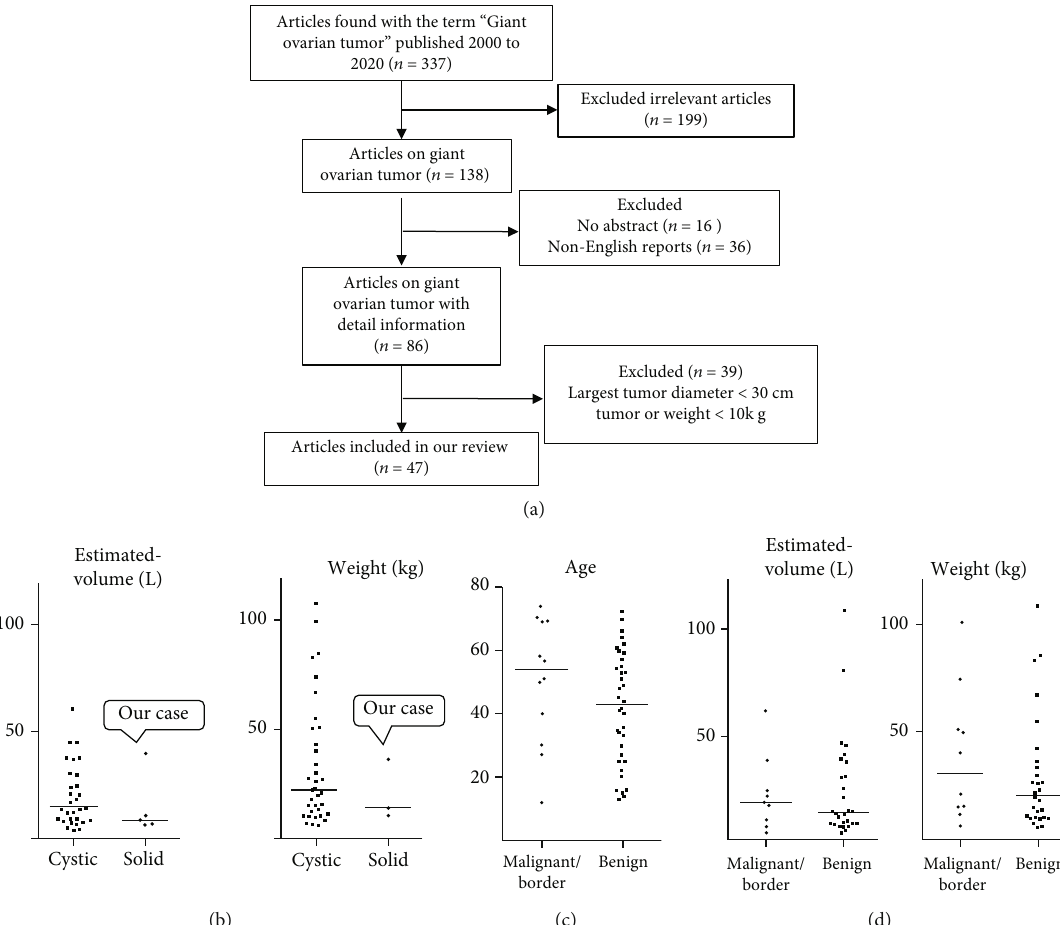
Figure 4: Literature review: fl ow and comparison of cystic and solid, begin, and borderline/malignancy. (a) Schematic of review. Case reports published from 2000 to 2020 were searched. We de fi ned ExG-OvTs as (1) tumors with a maximum diameter > 30cm in imaging or (2) tumors weighing more than 20kg. As a result, 48 cases were reviewed including our case. (b) Comparison of estimated volume (left side) and weight (right side) between cystic and substantial tumors. (c) Comparison of age between benign and malignant/borderline tumors. (d) Comparison of estimated volume (left side) and weight (right side) between benign and malignant/borderline tumors.